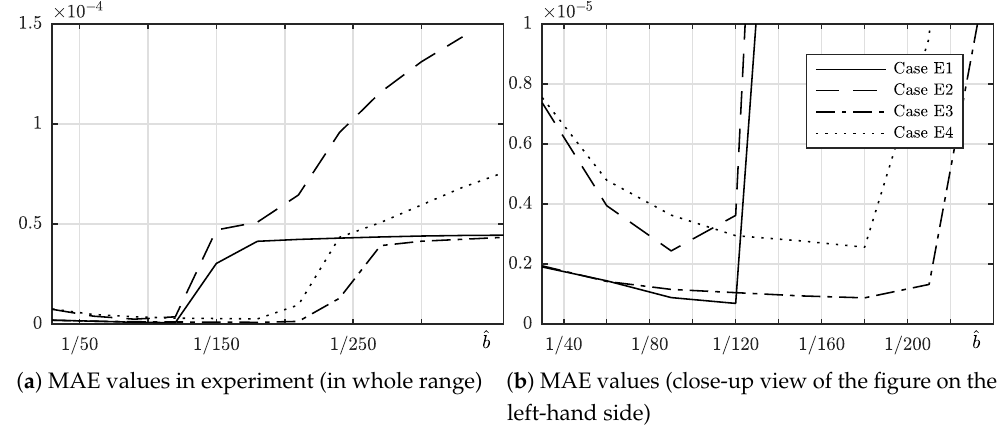
Figure 6. Values of MAE criterion(in radians) in the